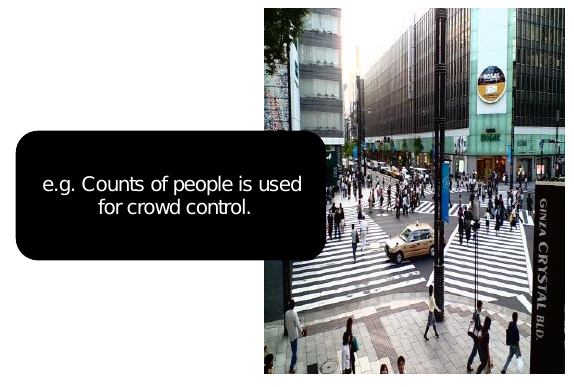
Figure 1: Shows the crowded